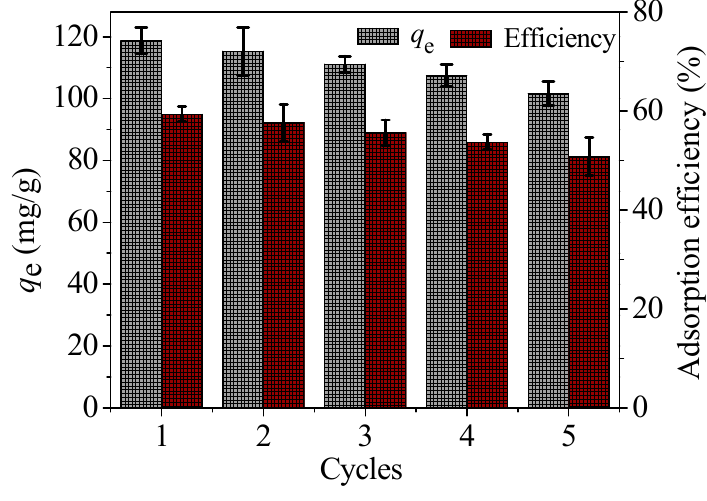
Figure 14. Desorption/regeneration cycles of CoFe 2 O 4 @SiO 2 –NH 2 .